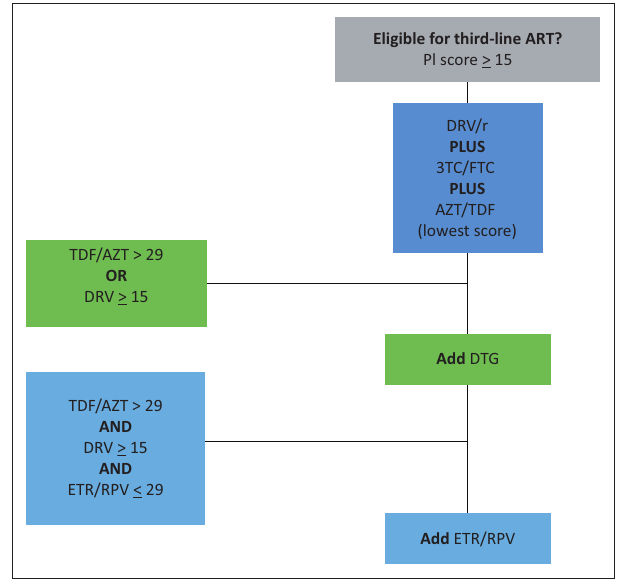
FIGURE 2: Algorithm for choosing drugs in third-line antiretroviral therapy regimen based on Stanford database